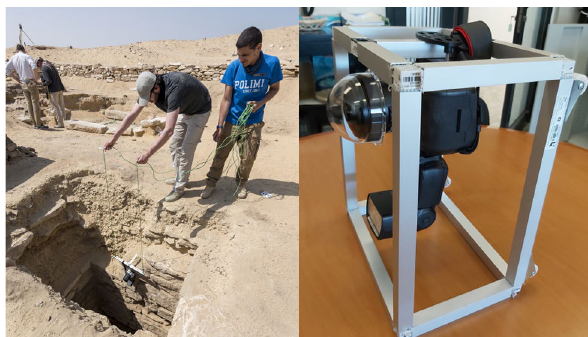
Figure 10 . On the left the survey of a shaft in Saqqara in 2018, on the right the design of a wired wheeled cage to survey vertical shafts, designed and assembled in